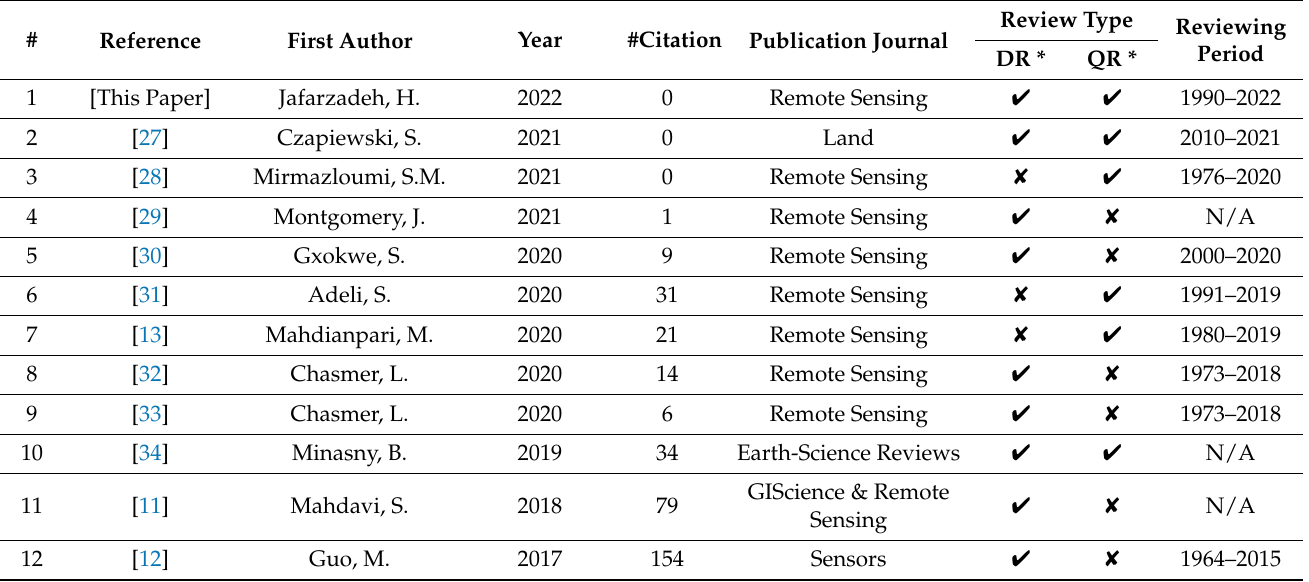
Table 1. List and a brief summary of previous reviews related to the topic. The list was sorted by publication date (the number of citations is reported by 30 June 2022 on the WoS